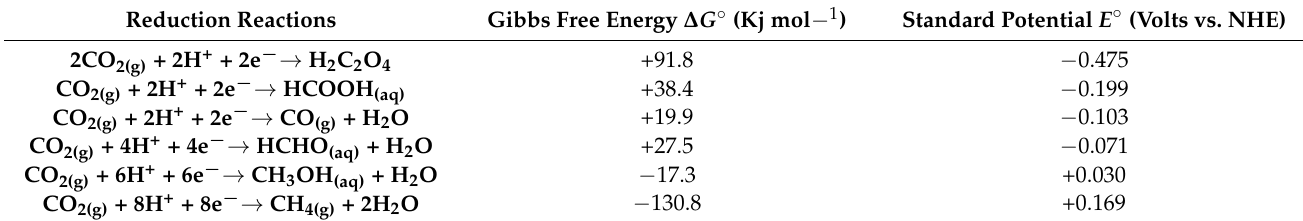
Table 1. Equilibrium potential and Gibbs free energy for CO 2 reduction reactions. Reduction